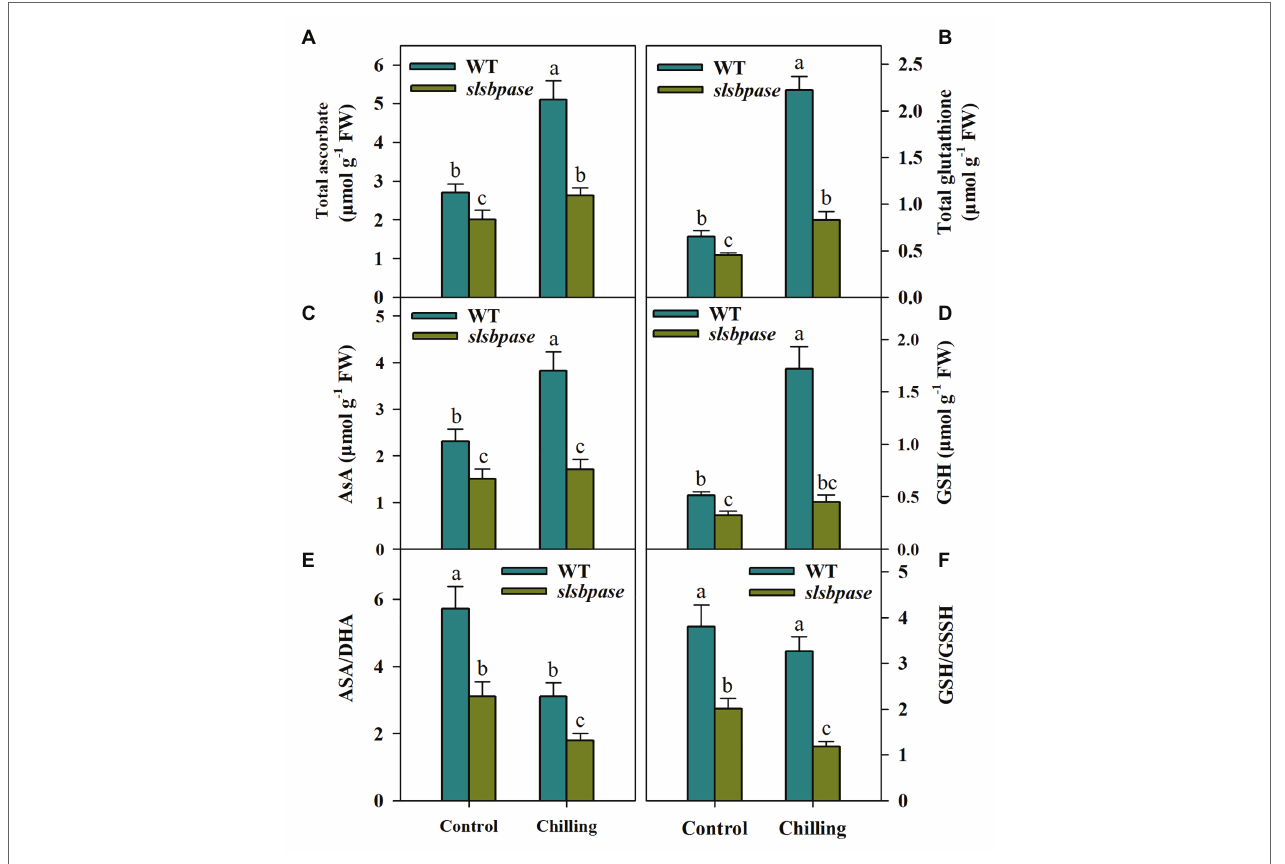
FIGURE 4 | Levels of ascorbate (AsA) and glutathione (GSH) in the AsA-GSH pathway as affected by SlSBPASE mutation in chilling-stressed tomato plants. (A) Total AsA; (B) total GSH; (C) AsA; (D) GSH; (E) AsA/DHA ratio; and (F) GSH/GSSH. At the fourth-leaf stage, slsbpase mutants and wild-type plants were subjected to a 24 h chilling stress. Following that, leaves from different groups were sampled for the determination of AsA and GSH contents. The results are mean values ± SDs from three independent experiments, and different letters on top of each column represent significantly different values at p < 0.05 among